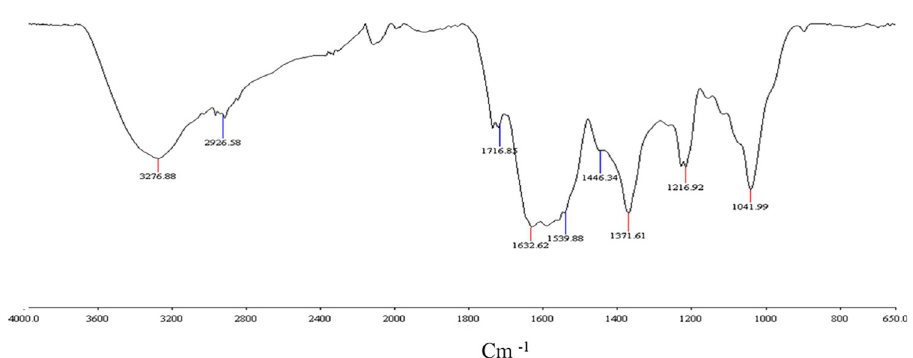
Fig 1. FTIR-DRIFT spectrum of humic substances from fennel green compost.